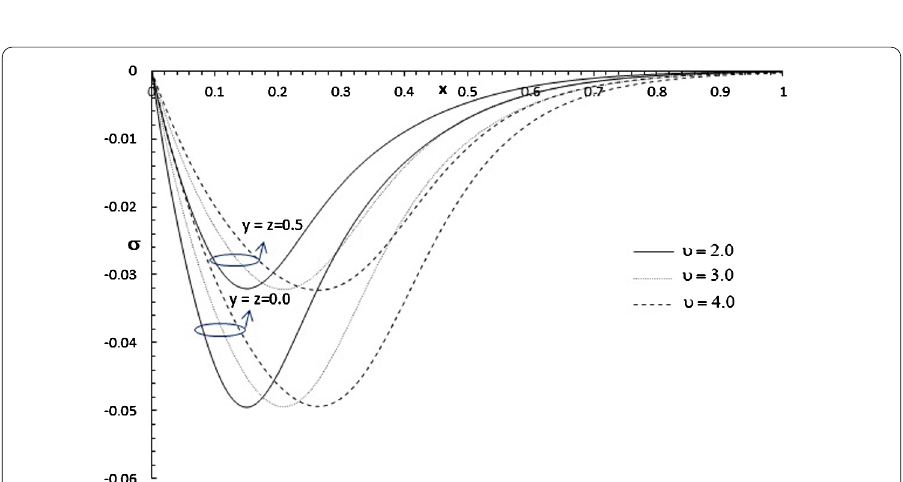
Figure 3 The stress distribution for various values of heat source speed